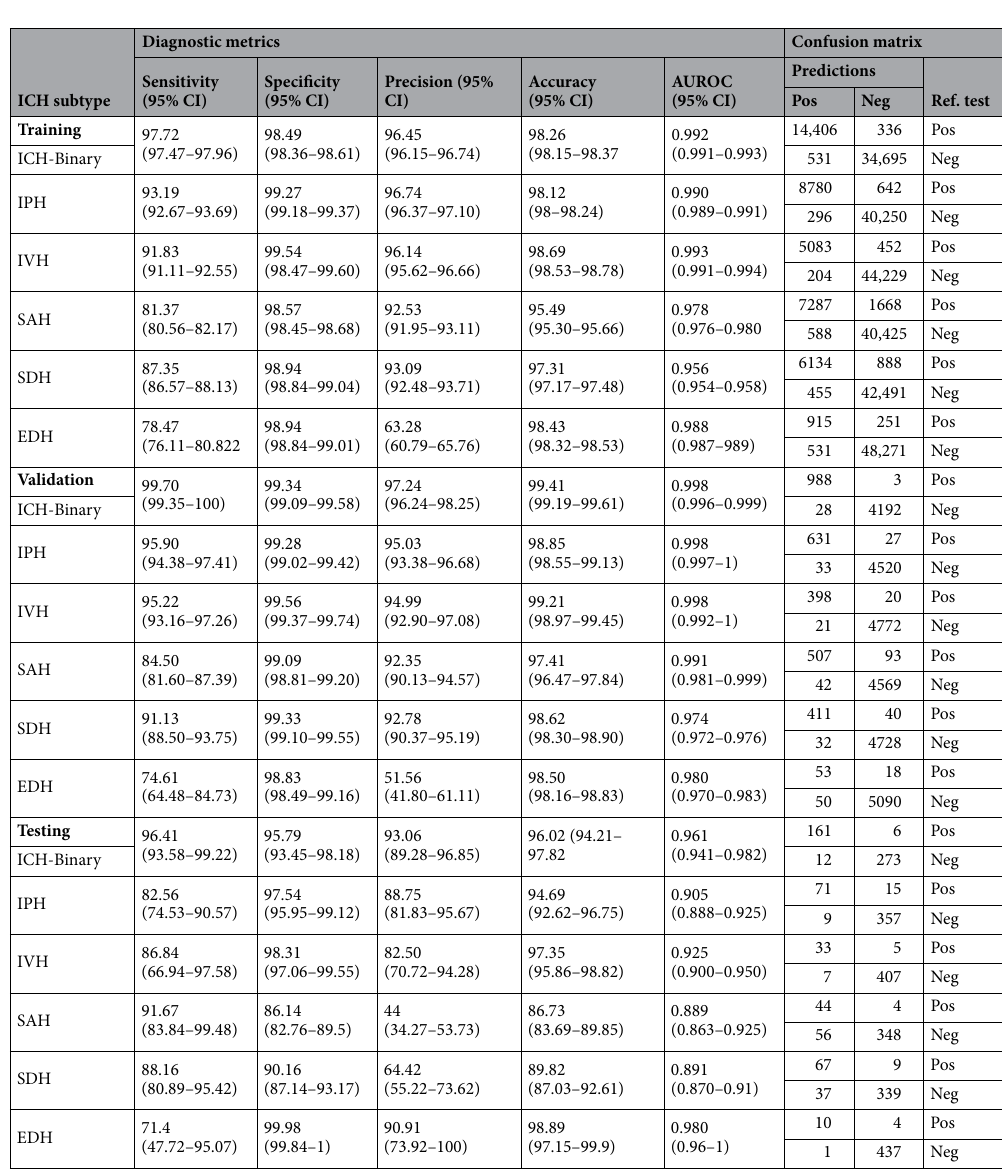
Table 2. Diagnostic performance of the unified CNN-RNN model on the training, validation, and testing sets. * EDH epidural hemorrhage, ICH intracranial hemorrhage, IPH intra-parenchymal hemorrhage, SAH subarachnoid hemorrhage, SDH subdural